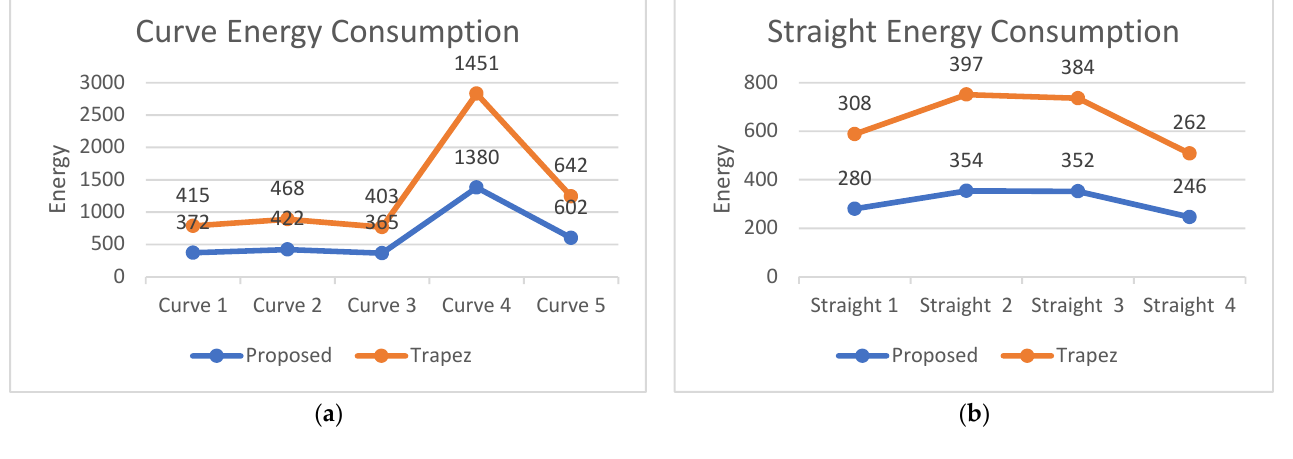
Figure 14. Proposed and Trapeze speed profiles: ( a ) curve energy consumption: Vmax=1.2, ( b ) straight energy consumption: Vmax=1.5.